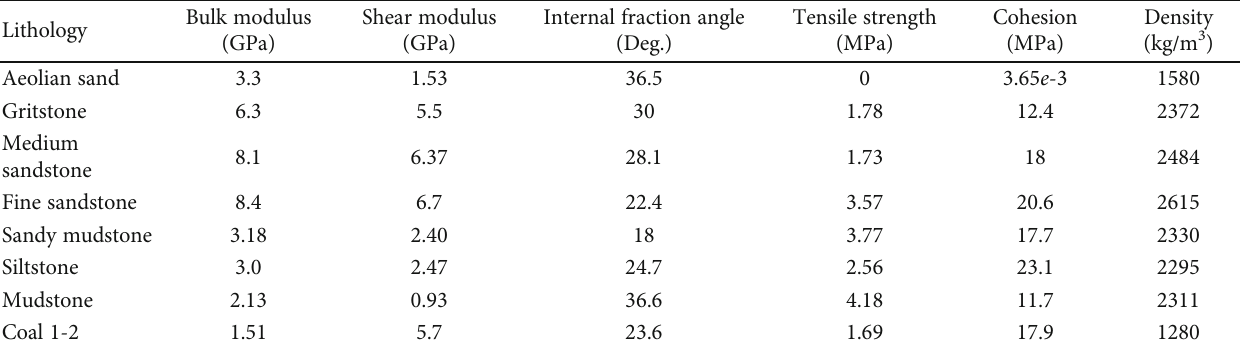
Table 2: Physical and mechanical parameters of coal and rock